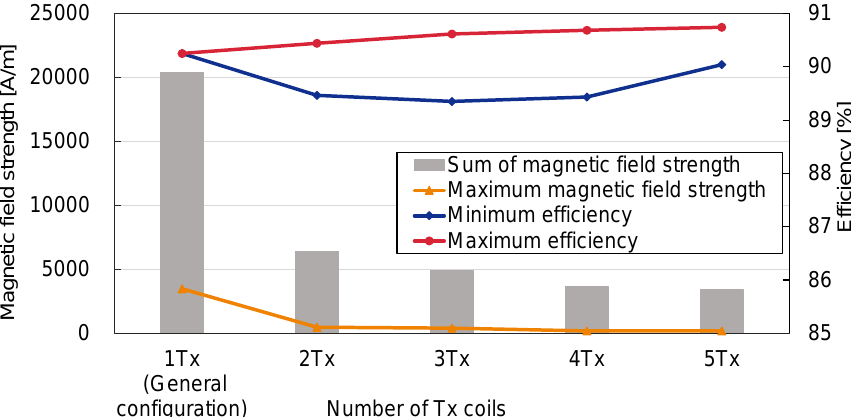
Figure 7. Comparison of magnetic field strength and transmission efficiency for each number of transmission (Tx) coils ( α = 0.1).